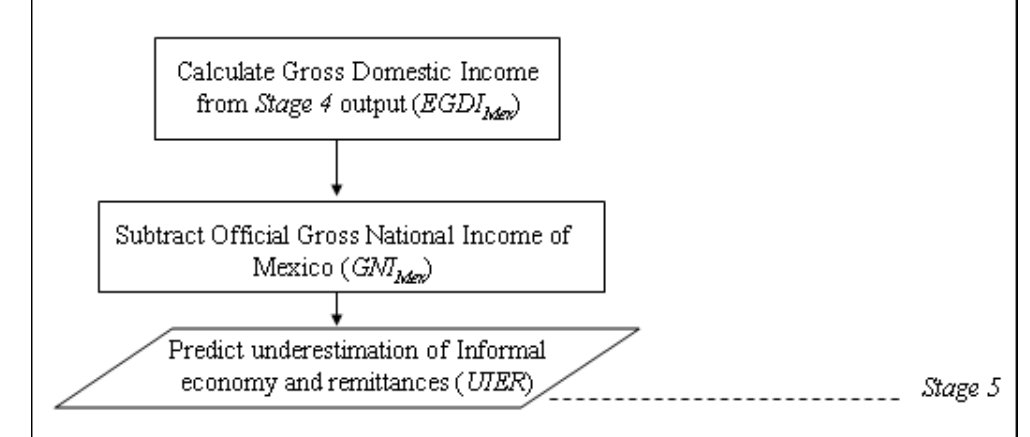
Figure 12. Stage 5 of the model: output is predicted underestimation of the informal economy and remittances in the official GNI